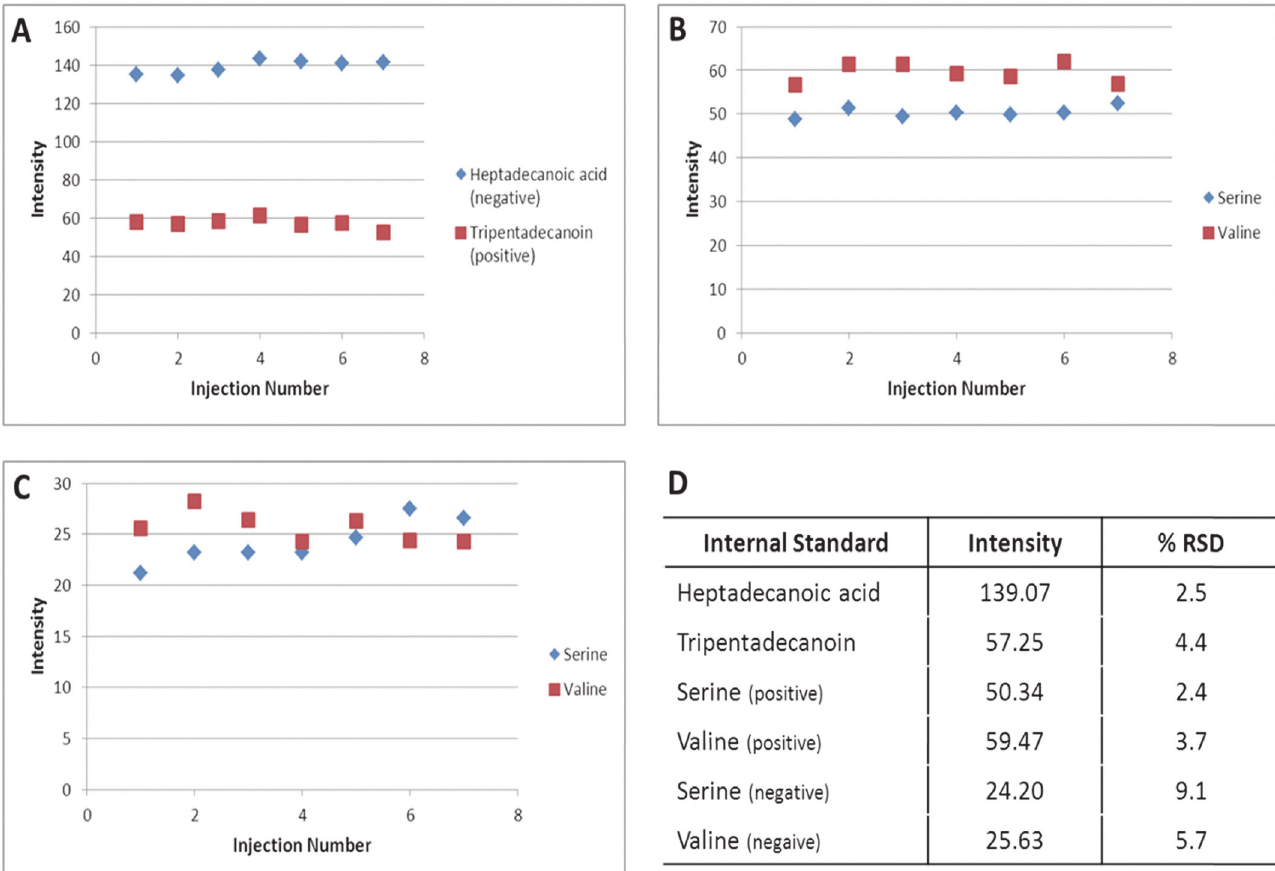
Fig 3. Recoveries of HILIC and reversed phase internal standards in experiment 1. A) plot of intensity of reversed phase internal standards Heptadecanoic acid (negative) and Tripentadecanoin (positive), B) plot of intensity of HILIC internal standards in positive ionisation mode, C) plot of intensity of HILIC internal standards in negative ionisation mode, D) average intensity and coefficient of variance of all internal standards.